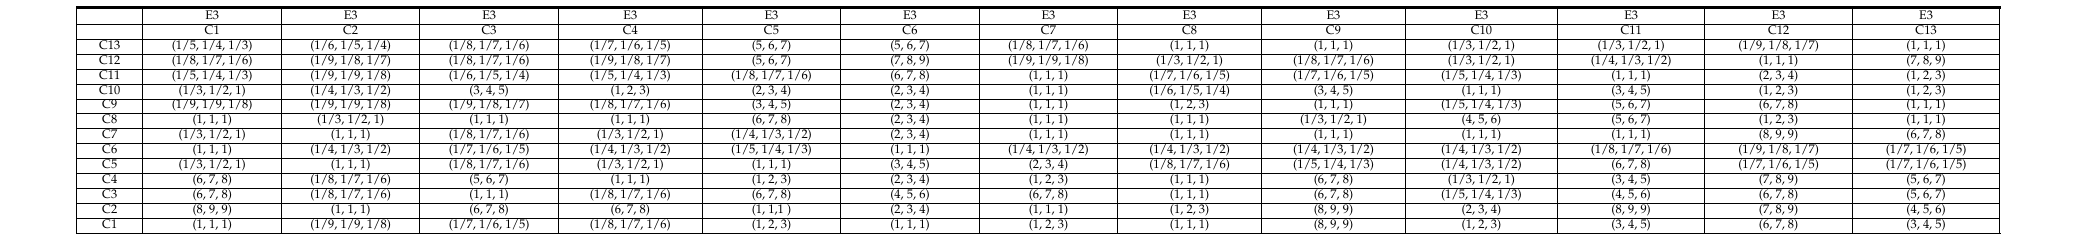
Table A3. Decision Matrix by expert 3 for TFN